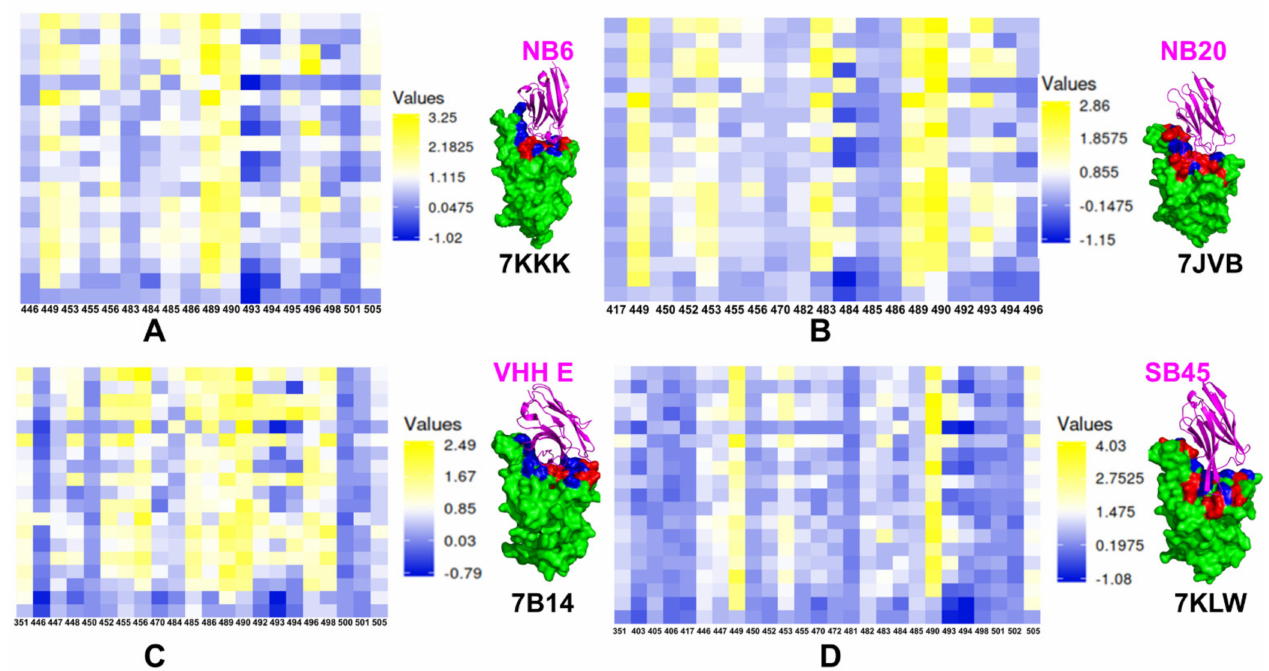
Figure 5. Mutational profiling of the SARS-CoV-2 S binding with class I nanobodies. ( A ) The muta- tional scanning heatmap for the SARS-CoV-2 S complex with Nb6 nanobody and structural map of the S-RBD binding epitope in the complex with Nb6. The S-RBD is shown in green surface. The epi- tope residues are shown in red and the binding energy hotspots from are shown in blue surface. ( B ) The mutational scanning heatmap and structural map for the SARS-CoV-2 S complex with Nb20 nanobody. The annotations for the epitope residues and the binding energy hotspots are as in panel A. ( C ) The mutational scanning heatmap and structural map for the SARS-CoV-2 S complex with VHH E nanobody. The annotations for the epitope residues and the binding energy hotspots are as in panel A. ( D ) The mutational scanning heatmap and structural map for the SARS-CoV-2 S complex with Sb45 nanobody. The annotations for the epitope residues and the binding energy hotspots are as in panel A. The heatmaps show the computed binding free energy changes for 19 single mutations on the binding epitope sites. The squares on the heatmap are colored using a 3-colored scale from blue to yellow with yellow indicating the largest unfavorable effect on